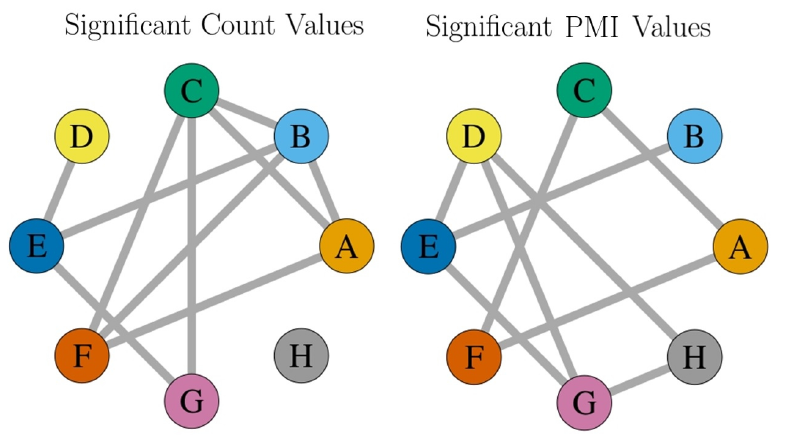
Figure 9. Network constructed from significant count values and significant PMI values in compari- son to the null